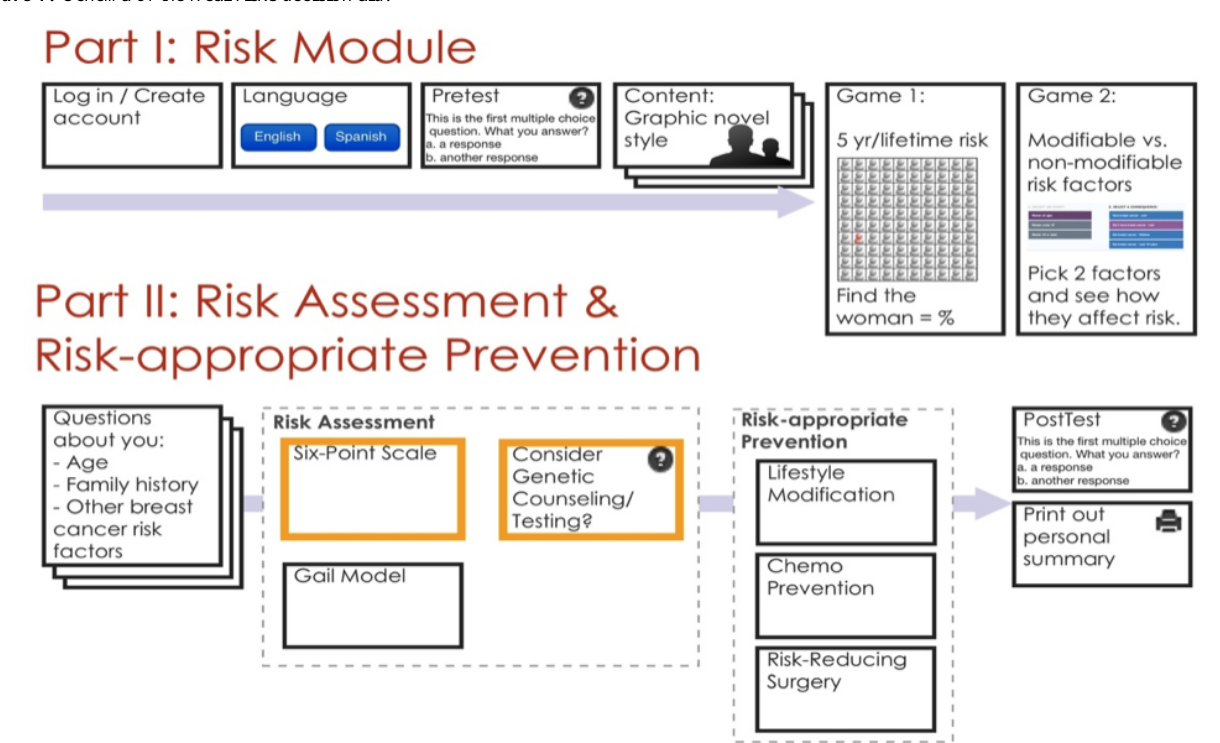
Figure 1. Schema of the RealRisks decision